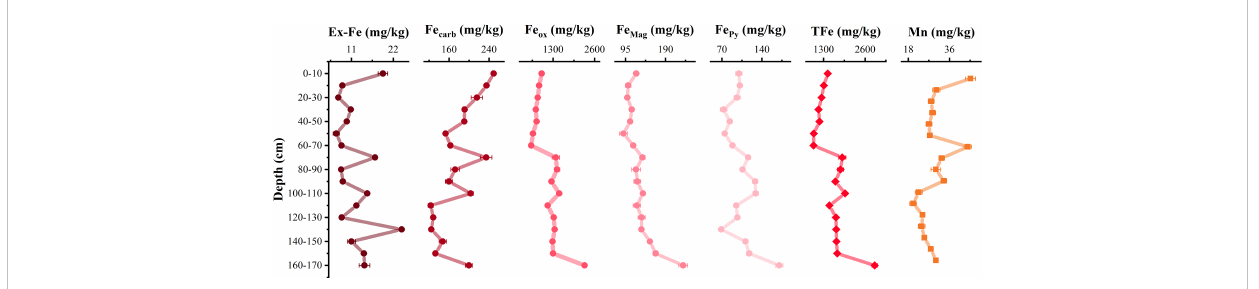
FIGURE 3 Distribution of different speciations of iron minerals at vertical pro fi le. Ex-Fe represents exchangeable iron, Fe carb represents low-crystallinity Fe- bearing carbonates, Fe ox represents easy-reduced iron oxide, Fe Mag represents high-crystallinity magnetite, Fe Py represents high crystallinity. Non- reactive pyrite, TFe represents the total content of iron minerals, and Mn represents the occurrence of manganese hosted in iron minerals.